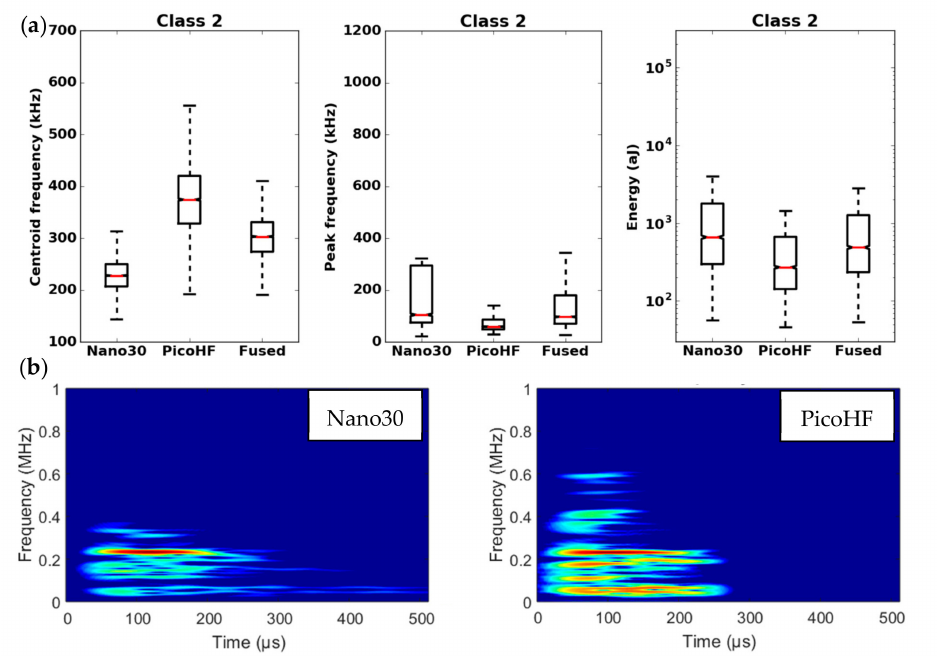
Figure 18. Results of the classification with an unsupervised classification based on fused features. ( a ) Characteristics of class 2 (frequency centroid, peak frequency and energy) viewed by the Nano30 sensor, PicoHF or with merged descriptors. ( b ) Representation in time / frequency domain with the SPWVD of the same AE signal recorded by Nano30 sensor and PicoHF sensor for class